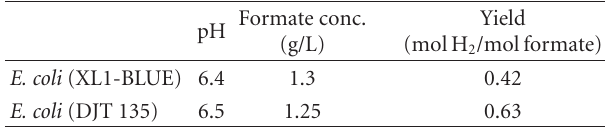
Table 4: The statistically determined optimum conditions for hy- drogen production.